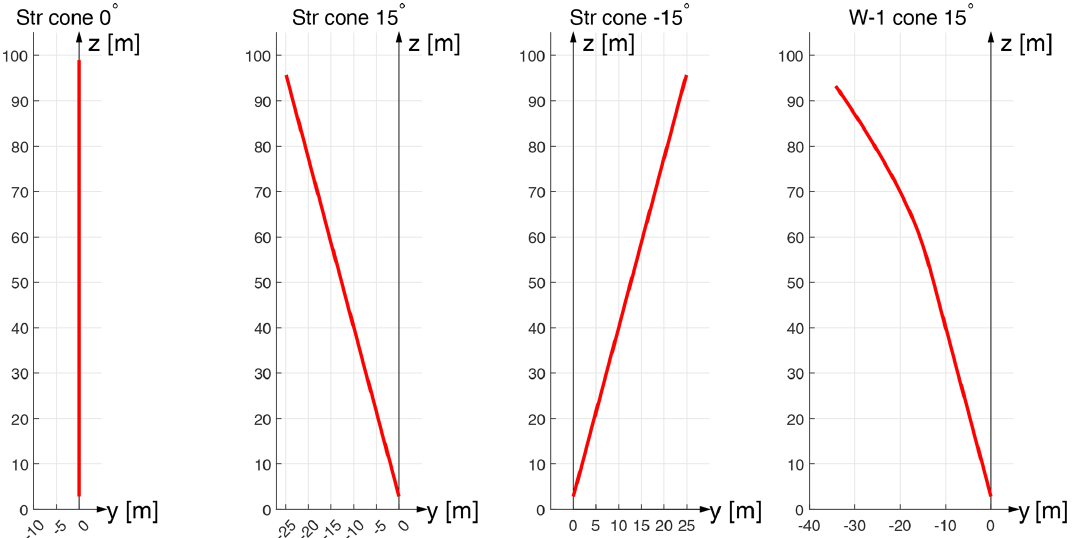
Figure 4. Side view of the main axes of the blades used for different cases of the comparison. The blades from left to right are the baseline straight blade with zero cone angle, 15 ◦ upwind coning, 15 ◦ downwind coning and the upwind dihedral blade W-1 with added 15 ◦ of upwind coning.